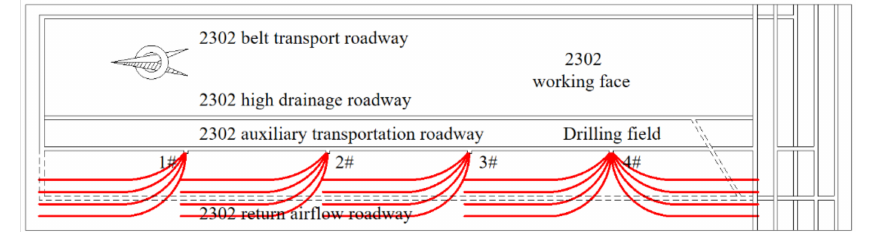
Figure 27. Borehole layout plan.